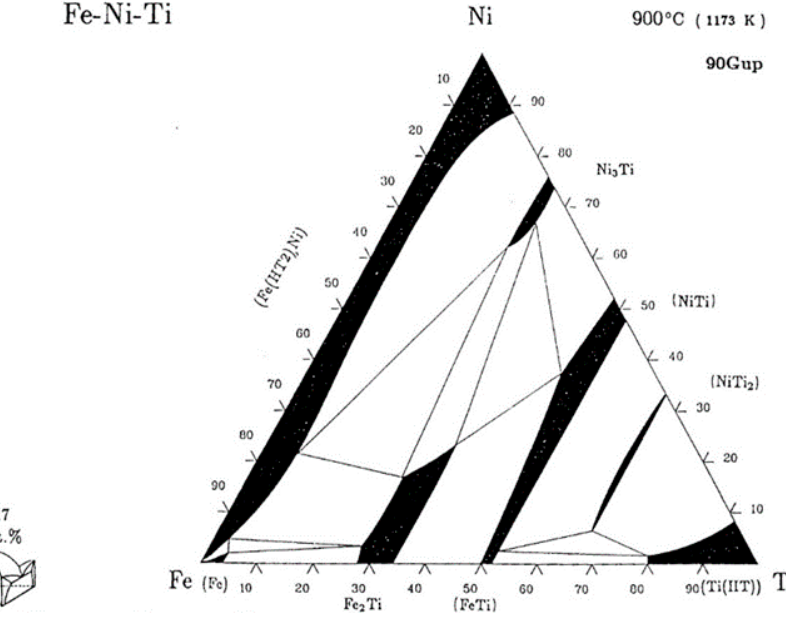
Figure 7. Isothermal section of Fe-Ni-Ti ternary phase diagram at 900 °C [19,23].